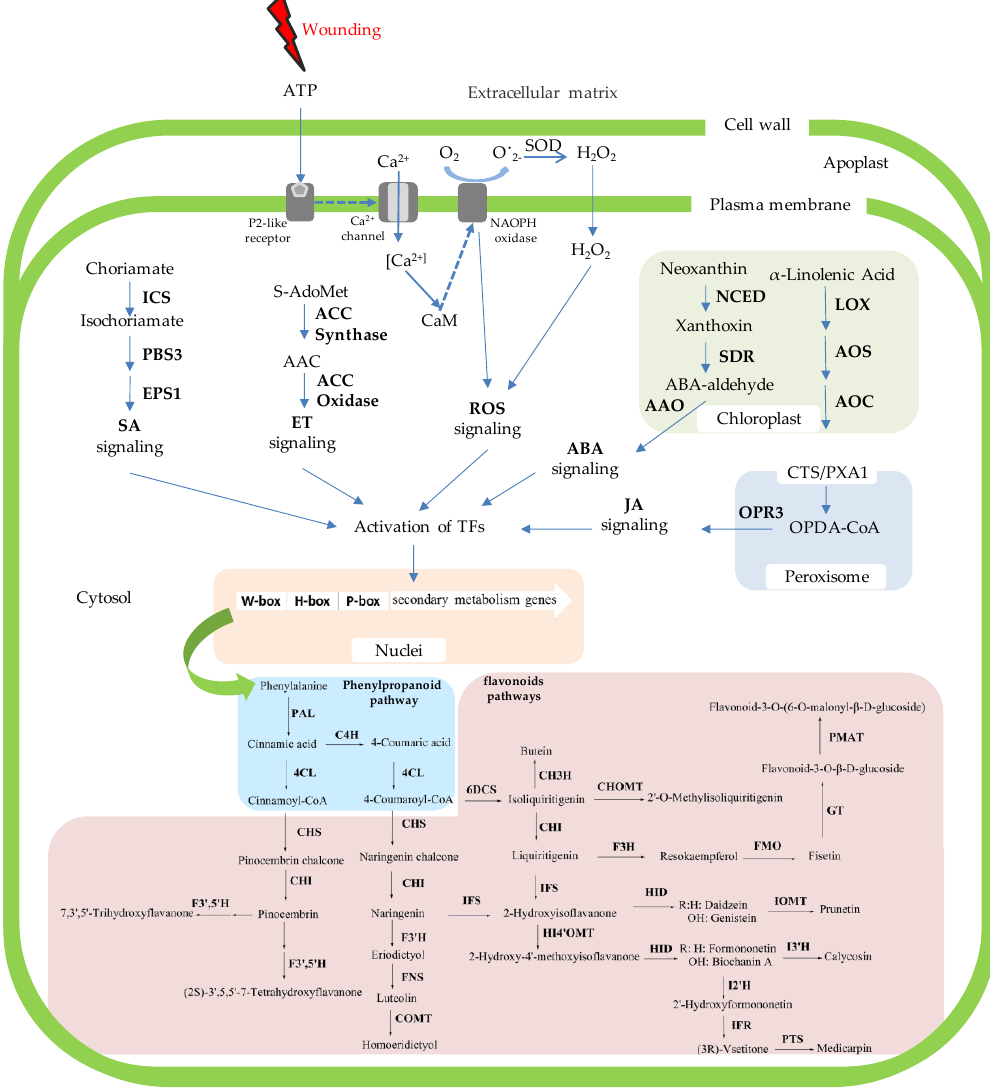
Figure 9. A model summarizing how wound-induced signaling regulates the phenylpropanoid and flavonoid biosynthesis pathways involved in heartwood production in D. odorifera